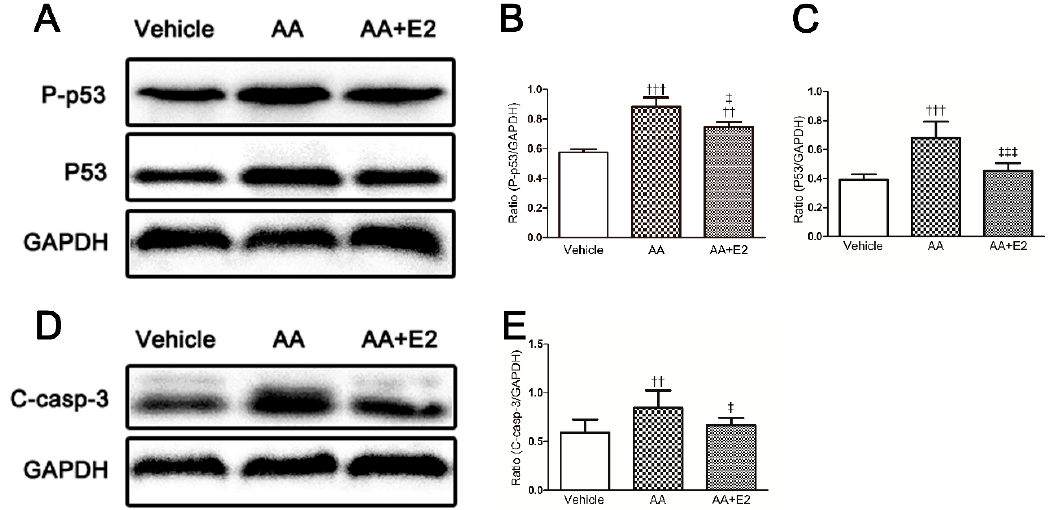
Figure 6. E2 downregulated p53 in renal tissue of acute AAN mice. ( A ) Phosphorylated p53 (P-p53) and p53 expression by western blotting; ( B ) Ratio between P-p53 and GAPDH measured from Western blots; ( C ) Ratio between p53 and GAPDH measured from Western blots; ( D ) Cleaved caspase-3 (C-casp-3) expression by Western blotting; ( E ) Ratio between C-casp-3 and GAPDH measured from Western blots. Data were expressed as mean ± SD for groups of 6 mice. †† p < 0.01, ††† p < 0.001 vs. vehicle group; ‡ p < 0.05, ‡‡ p < 0.01, ‡‡‡ p < 0.001 vs. AA group.